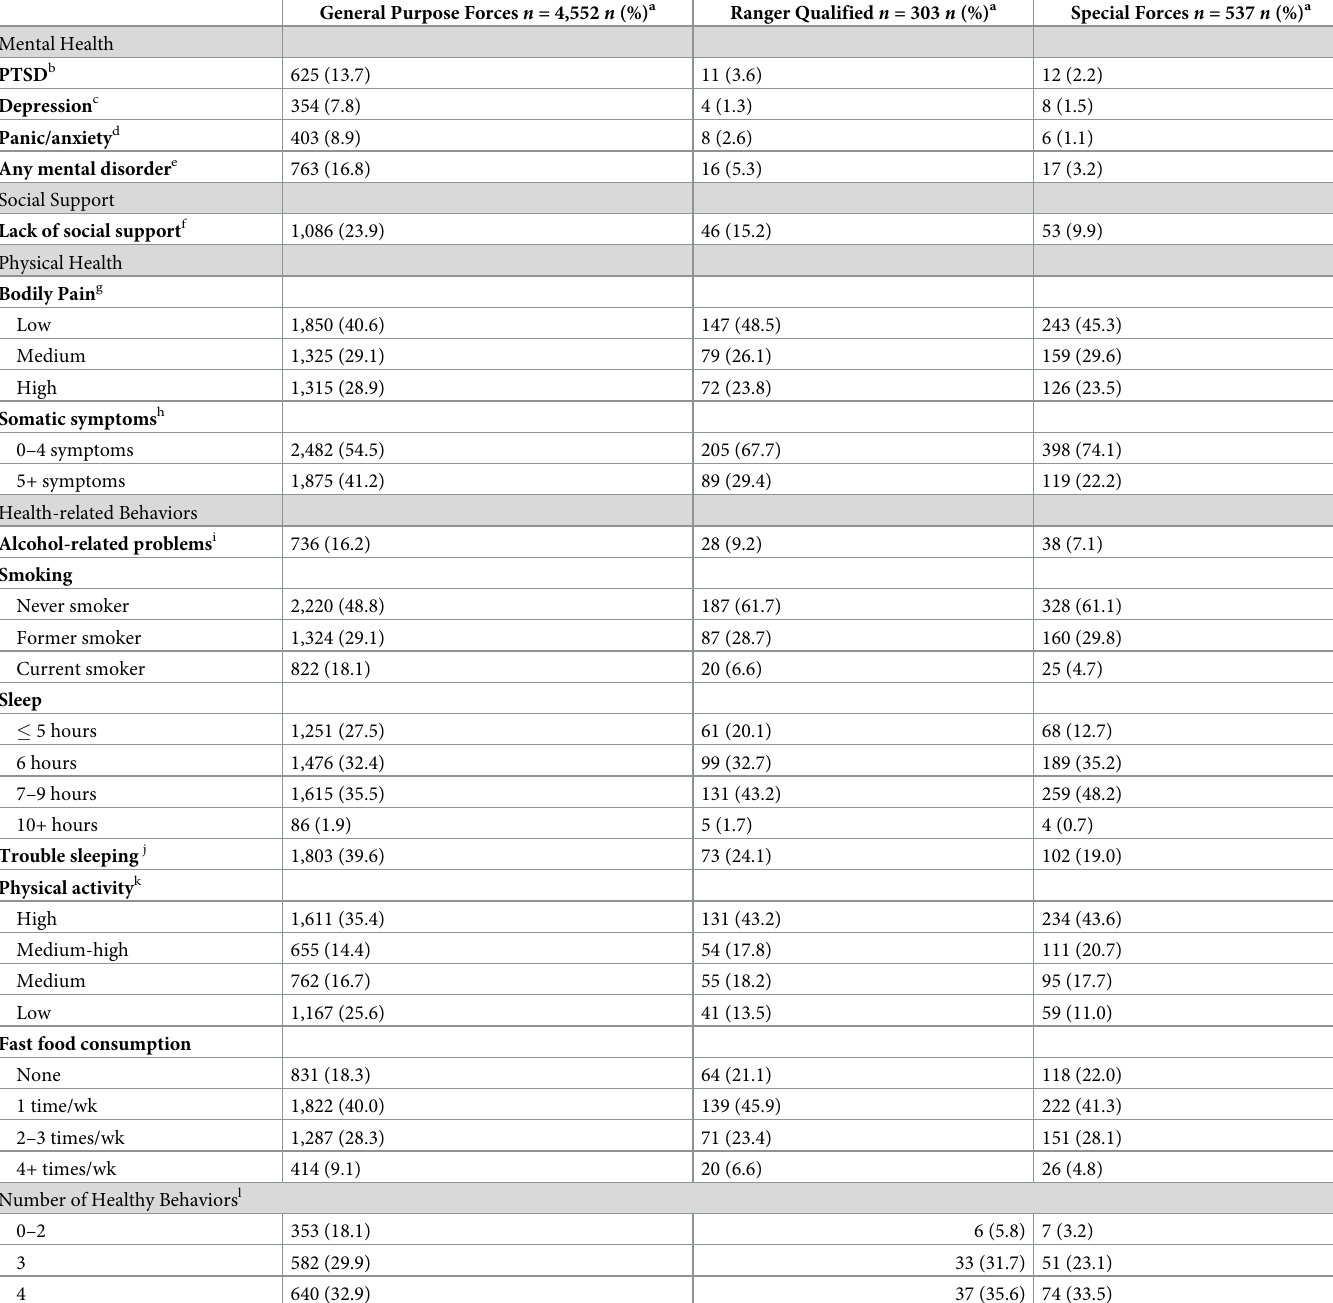
Table 2. Frequencies of mental health, social support, physical health, health-related behaviors, and number of healthy behaviors by Army specialization among soldiers, the Millennium Cohort Study �